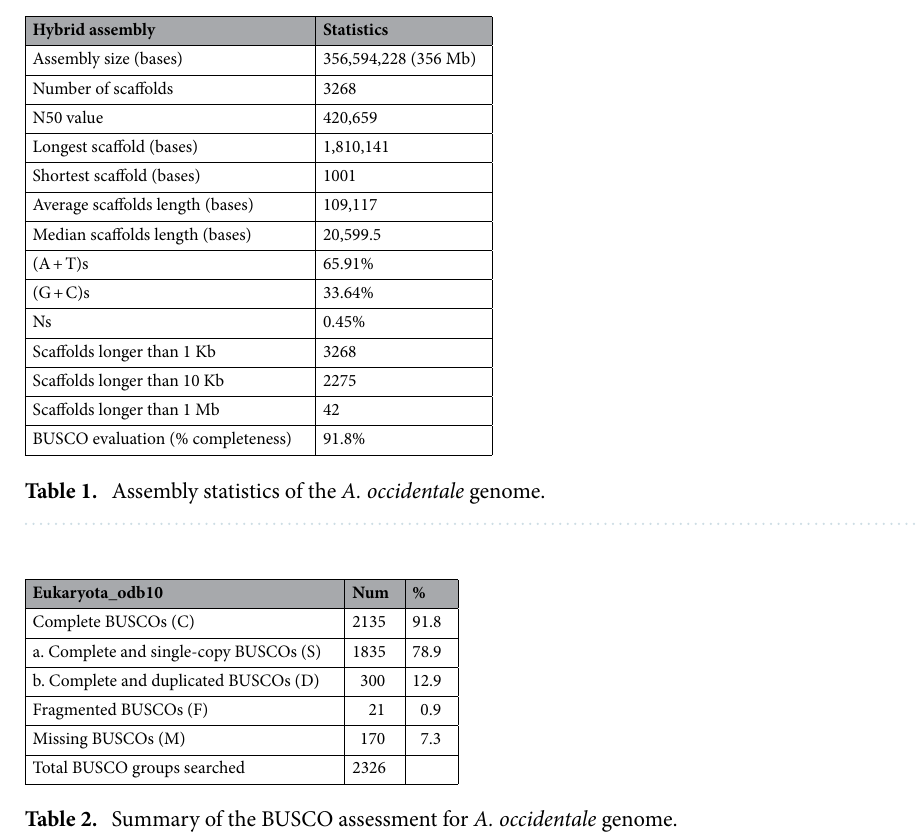
Table 2. Summary of the BUSCO assessment for A. occidentale